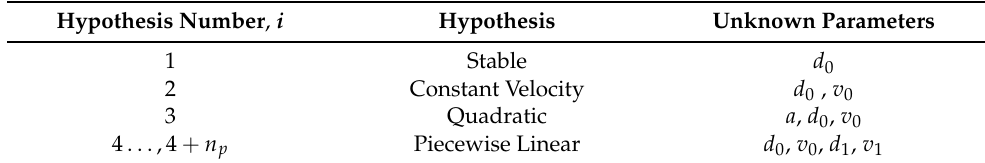
Table 1. List of hypotheses for nodal analysis and unknown parameters. Hypothesis Number ,